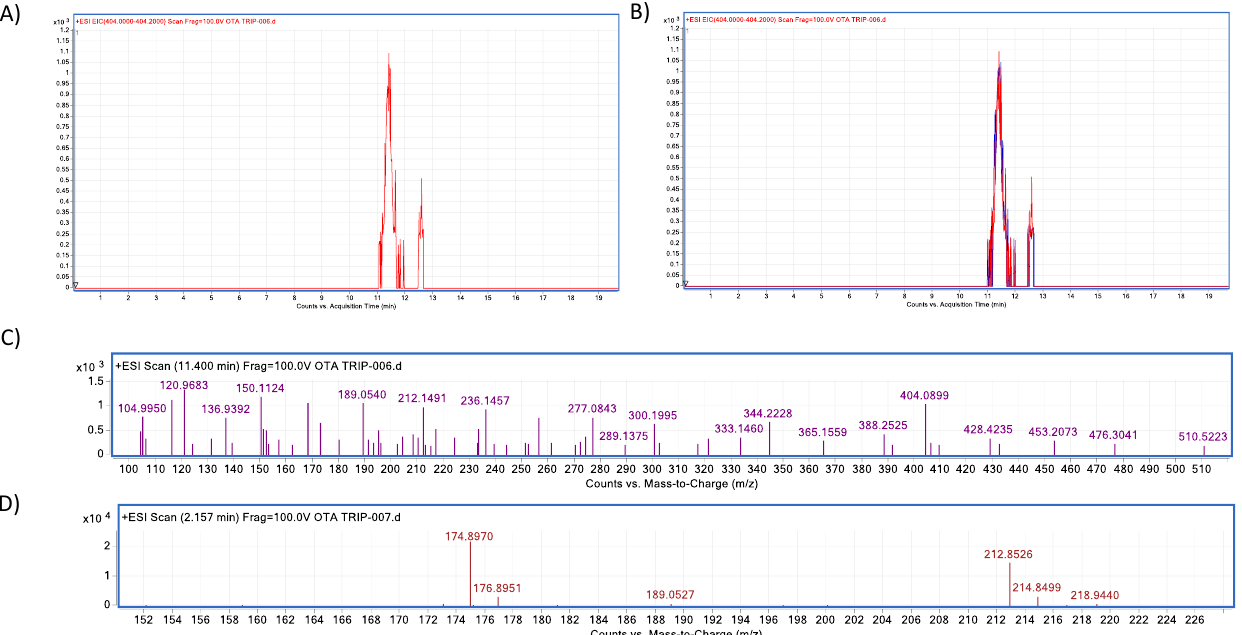
Figure 18. Trypsin–OTA biotransformation HPLC–TOF–MS chromatograms showing: ( A ) Ochratoxin (OTA) control peak; ( B ) Ochratoxin (OTA) peak in control (red) and experimental assays (blue); ( C ) OTA’s molecular ion as found in control tubes (M + 1) at 404.08 ( m / z ); ( D ) molecular ion (M + 1) of the most stable product of α –ochratoxin fragmentation at 212.85 ( m / z